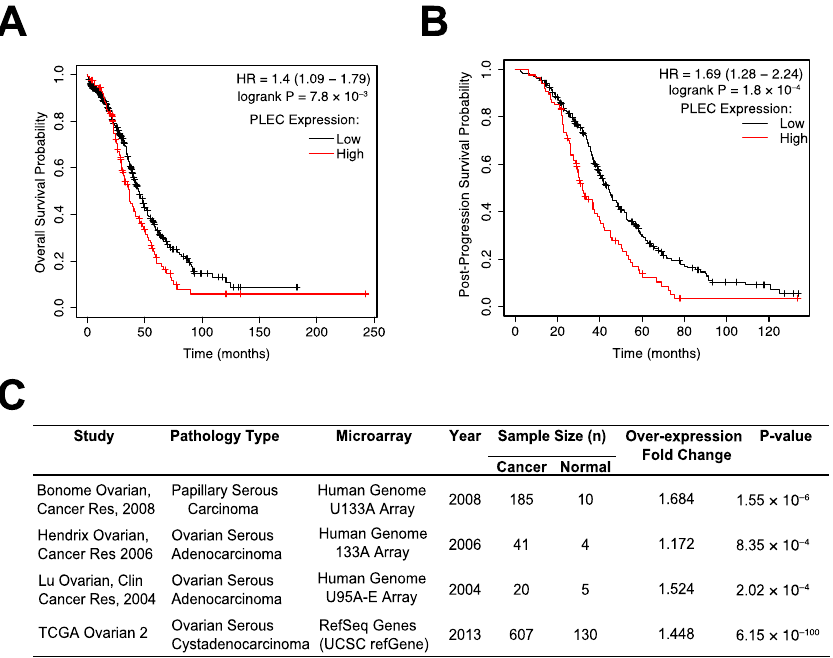
Figure 1. Higher levels of PLEC mRNA expression are associated with poor ovarian cancer patient survival. ( A , B ) The KM plotter database was used to evaluate the prognostic value of PLEC mRNA expression in OC’s most common subtype, TP53 mutant serous carcinoma. High PLEC expression is a significant indicator of ( A ) overall survival and ( B ) post-progression survival in this subset of patients. ( C ) A differential expression analysis using Oncomine revealed PLEC to be significantly overexpressed in OC tissues.